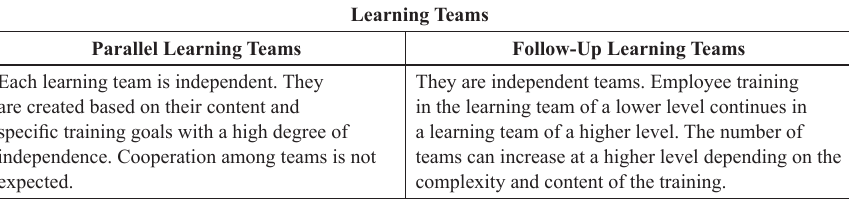
Table 4. Proposal of learning teams’